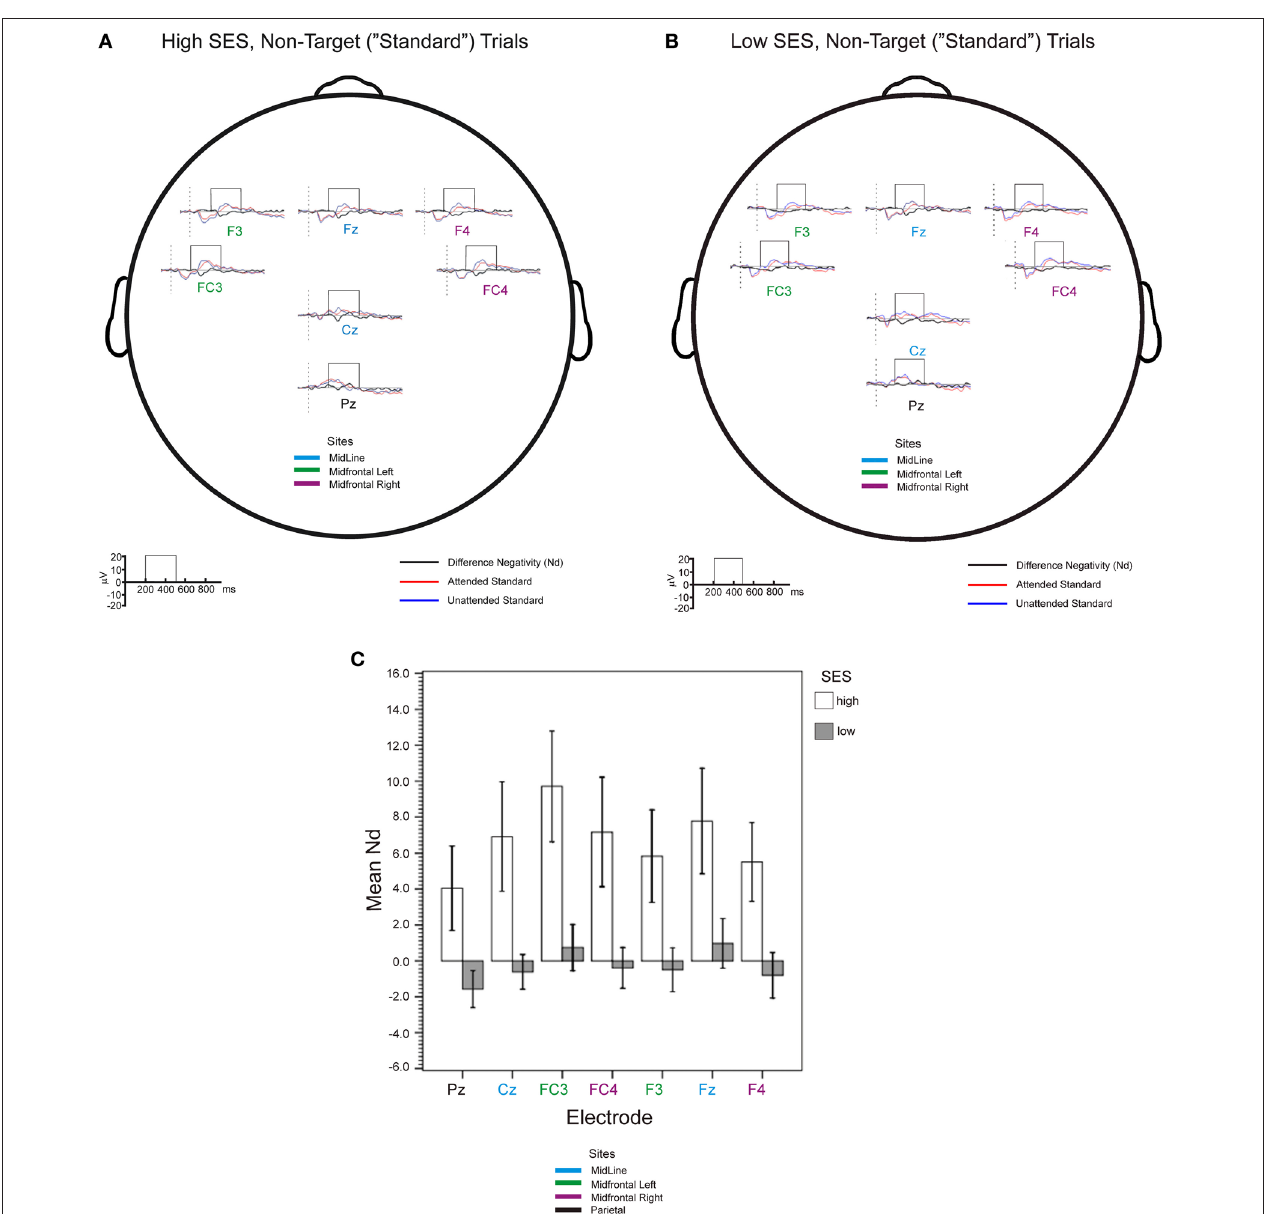
FIGURE 3 | Group-mean event-related potentials (0–30Hz) for the high-SES (A) and low-SES (B) children, averaged with respect to attended (red) and unattended (blue) tones are shown for high and low SES children at all tested electrode sites. Difference evoked